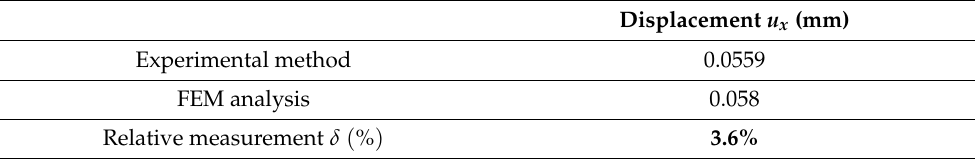
Table 10. Results for the sample with lamination angles ± 60 ◦